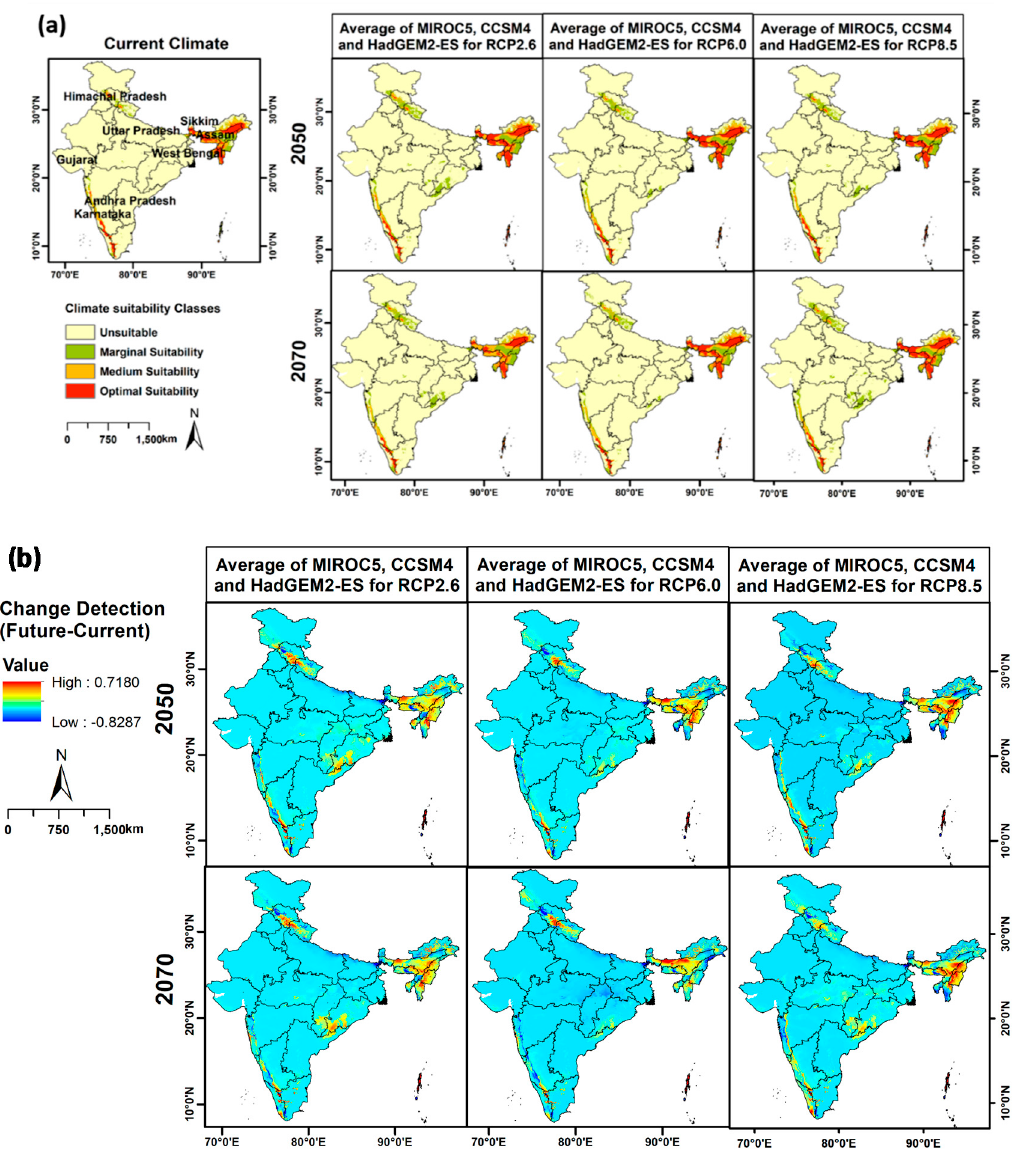
Figure 4. Current and future habitat suitability for Camellia sinensis in India ( a ) and change detection (loss or gain of suitability area) ( b ).